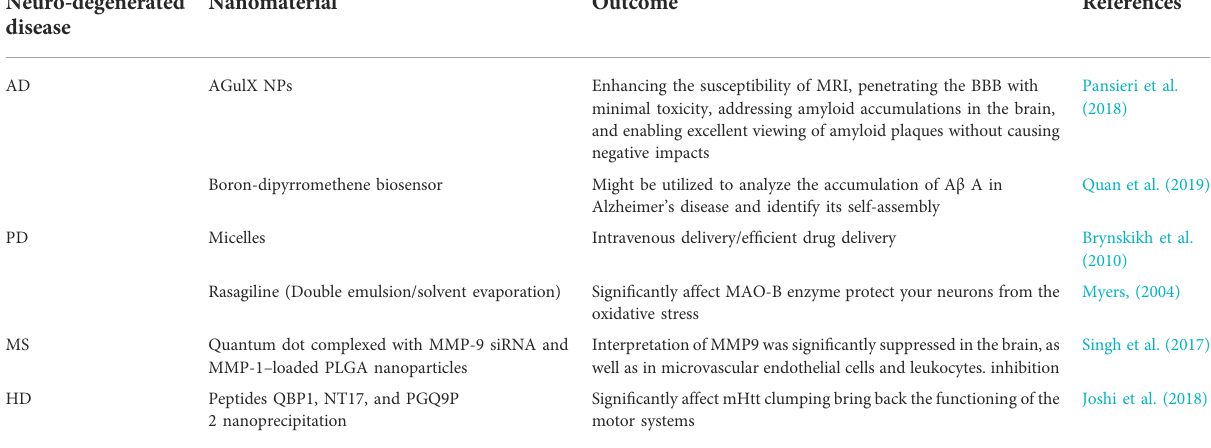
TABLE 4 Treatment of neurodegenerative disorders used various potential